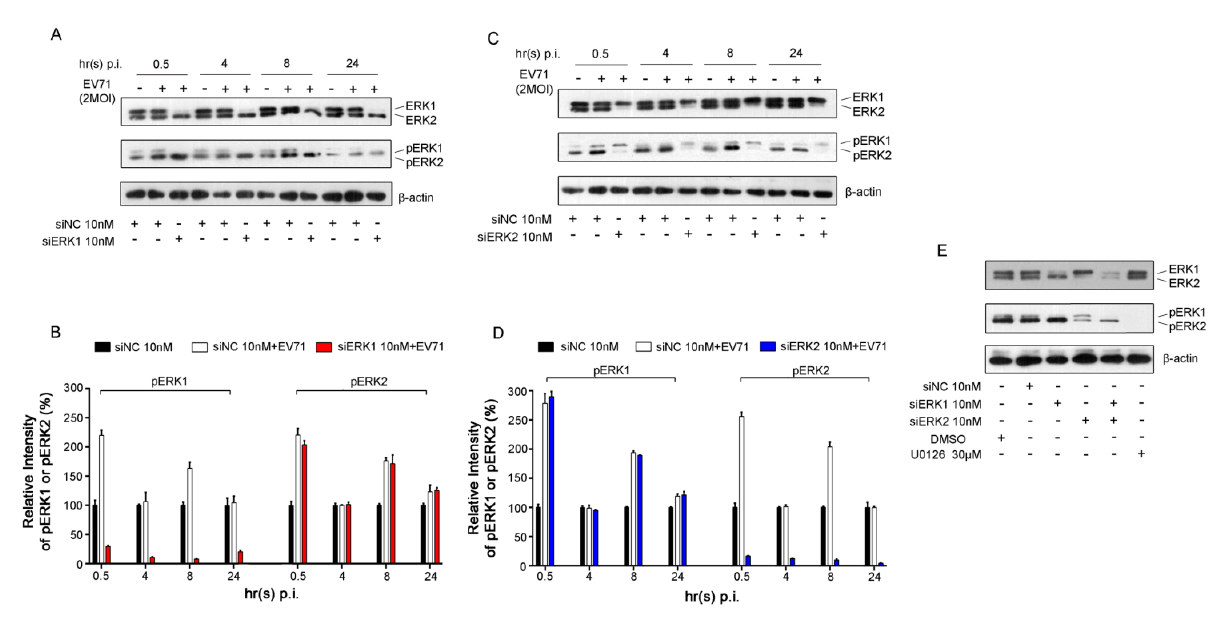
Figure 1. EV71-induced activation of ERK1/2 in Rhabdomyosarcoma (RD) cells. ( A ) RD cells were infected with EV71 (MOI = 2) at 36 h post-transfection with ERK1 siRNA (siERK1). Cells transfected with negative control siRNA (siNC) were used as controls. Cell lysates were collected at the indicated time points post infection (p.i.). ERK1/2, pERK1/2 and β-actin were detected by Western blot analysis, respectively; ( B ) The intensity of pERK1 or pERK2 normalized to that of corresponding ERK was determined by densitometric scanning based on the results from panel A; ( C ) The experiment was performed as described in panel A except that RD cells were transfected with ERK2 siRNA (siERK2); ( D ) Based on the results from panel C, the intensity was determined as described in panel B; ( E ) Cell lysates were collected from RD cells treated with siERK1, siERK2 and both (siERK1+2) at 36 h after transfection and cells treated with U0126 at 12 h after addition. ERK1/2 and pERK1/2 were blotted with specific antibodies. Experiments were repeated three